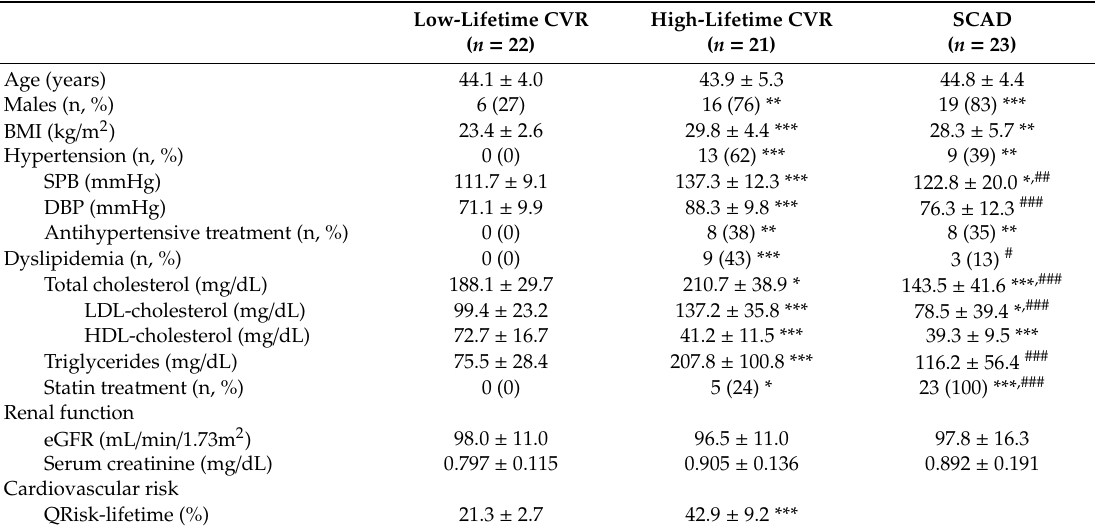
Table 1. Baseline characteristics of the study